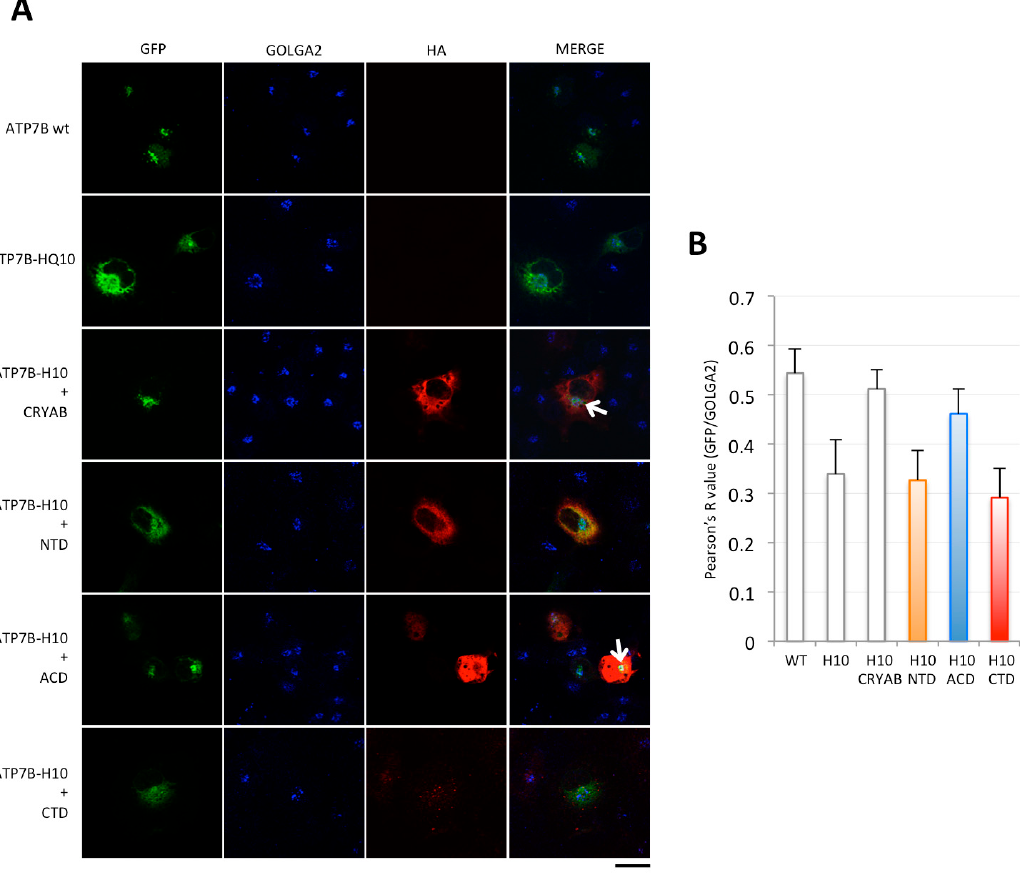
Figure 1. The α -Crystallin domain of CRYAB rescues Golgi localization of ATP7B-H1069Q mutant. ( A ) immunofluorescence analysis of COS7 cells transfected to express GFP-tagged ATP7B or ATP7B-H1069Q (ATP7B-H10) alone, or co-transfected to express full-length HA-tagged CRYAB or the isolated HA-tagged N-terminal (NTD), α -crystallin (ACD) and C-terminal (CTD) domains, as indicated on the left. After fixation, the cells were processed for triple confocal immunofluorescence analysis to reveal the Golgi complex with the marker GOLGA2. Note that the CTD was expressed at much lower level. White arrows point to region of GFP and GOLGA2 overlapping signal. Scale bar: 10 µ m; ( B ) colocalization analysis of GFP and GOLGA2 signals (mean ± SD, n = 20 cells from two independent experiments). Abbreviations as in A.